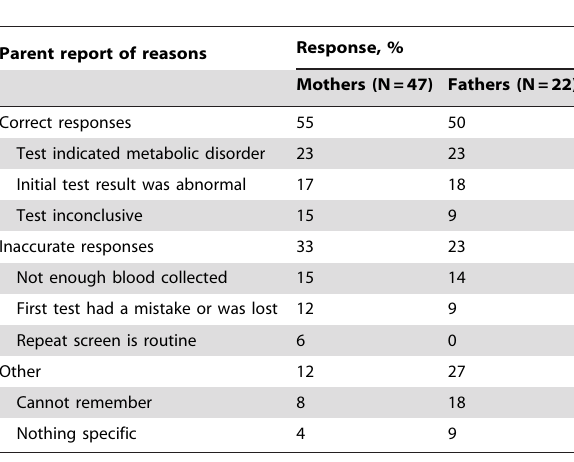
Table 3. Parents response to reason for repeat screen in false-positive